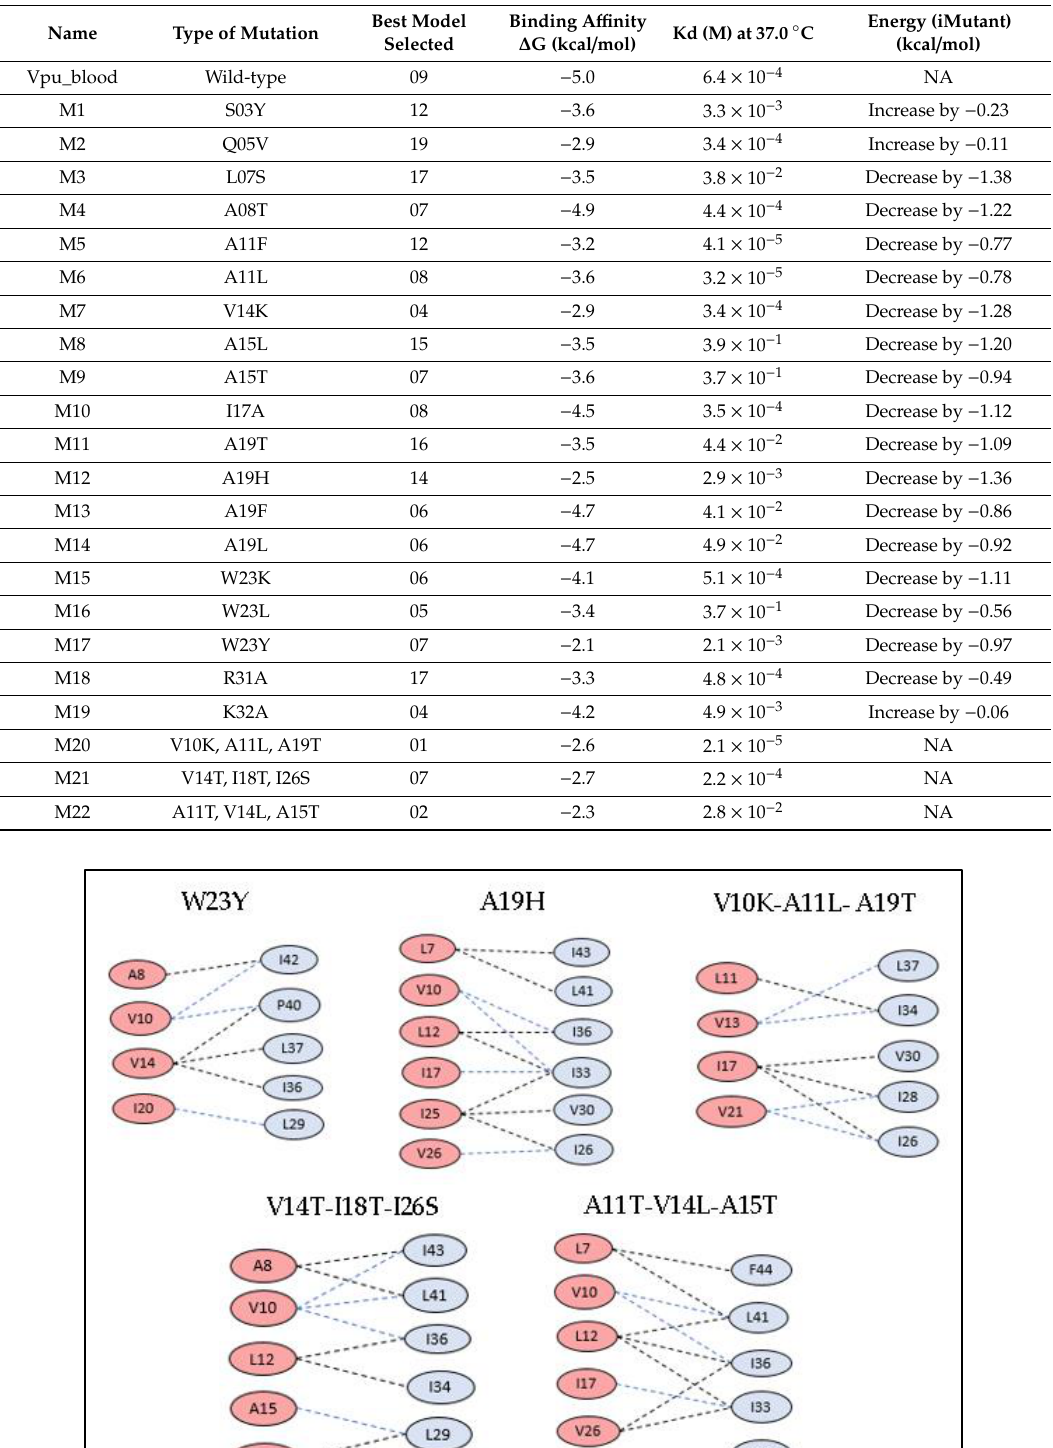
Table 6. This table represents the positions of mutations performed in Vpu, the best tetherin-Vpu interaction model (docked model) in Hex, binding a ffi nity of the respective docked complexes, and their Kd values.